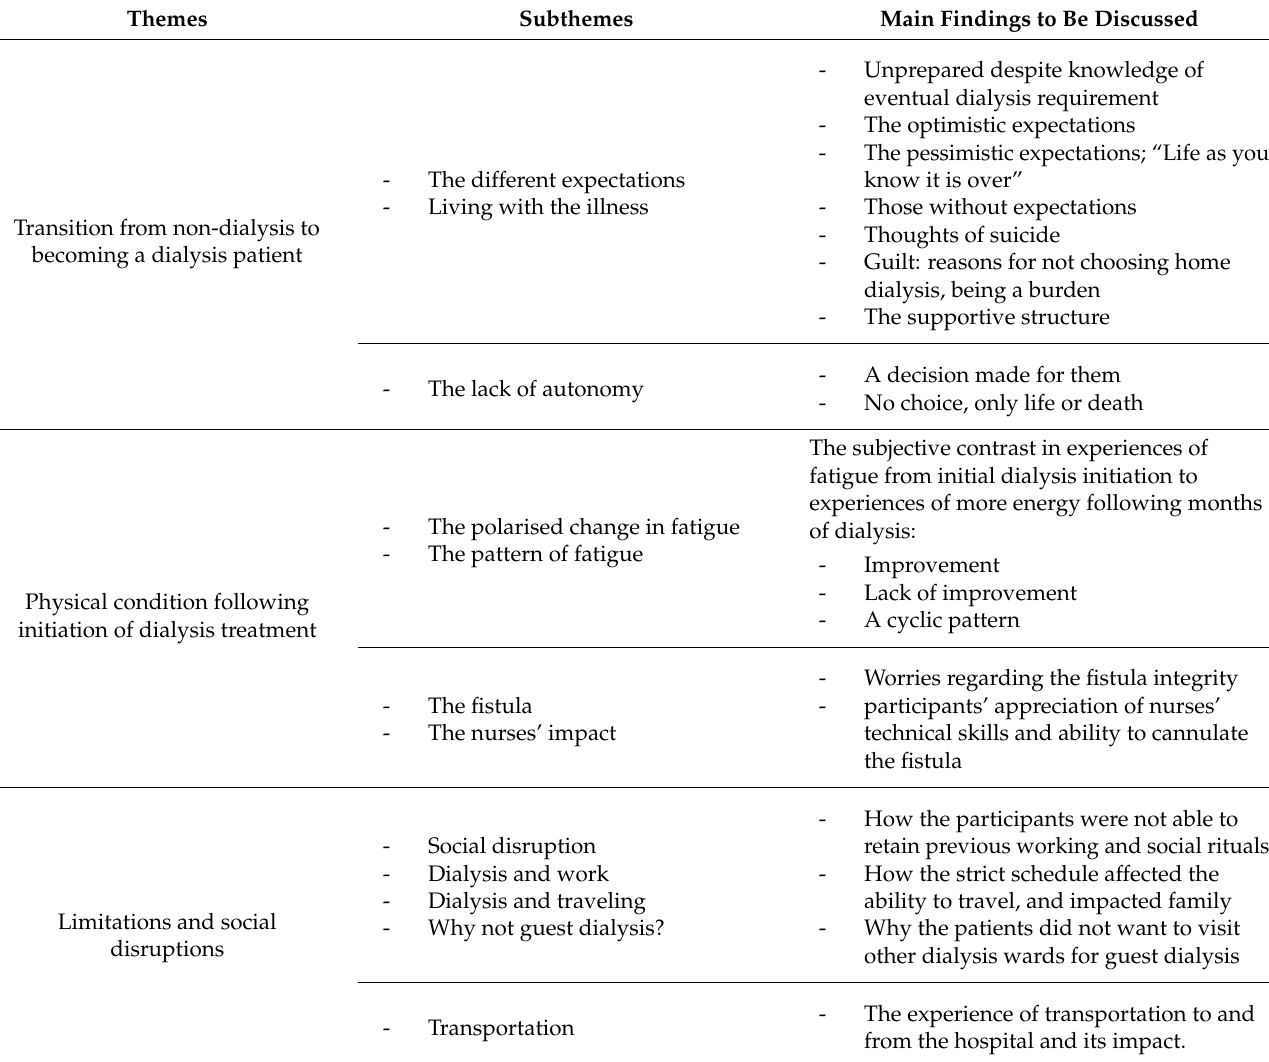
Table 2. Themes, subthemes, and main findings to be discussed in a study on patient preferences in relation to initiation of dialysis